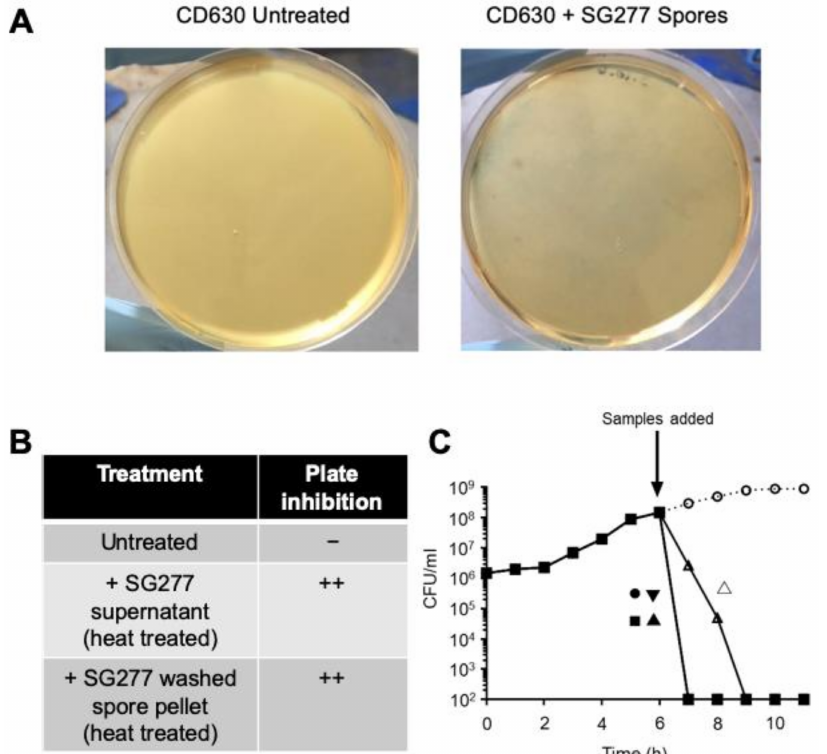
Figure 6. Inhibitory activity is associated with the surface of the cell and/or spore. ( A , B ) Heat-treated SG277 spores or supernatant were mixed in equal volumes with a logarithmic culture of CD630, added to 0.6% micropropagation agar and poured onto BHIS agar plates prior to anaerobic incubation (37 ◦ C, 18 h). ( A ) Inhibition was apparent compared against the turbid appearance of untreated CD630. ( B ) Both the SG277 heat-treated supernatant and the spore pellet demonstrated agar plate inhibition of CD630 culture. ( C ) Fractions of “active” material obtained from B. velezensis SG277 were added to exponentially growing CD630 and viable bacteria (CFU/mL) were determined. Aqueous materials were: • , cell-free supernatant; (cid:52) , spores, consisting of purified spores of SG277; (cid:4) , AmSO 4 precipitate; (cid:78) , SEC active fraction; (cid:72) , RP-HPLC purified